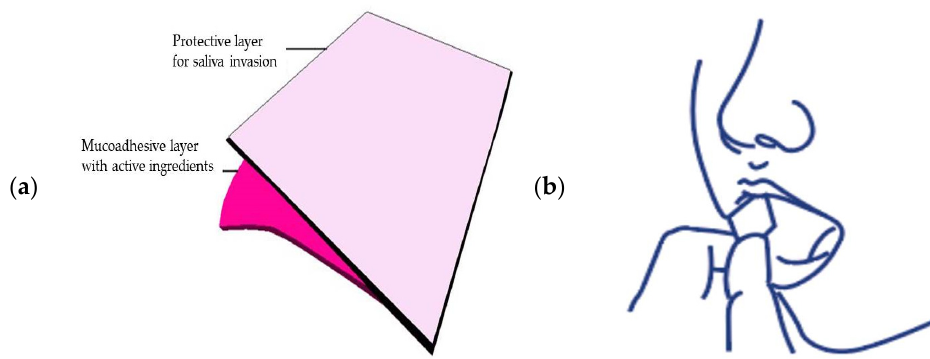
Figure 1. The schematic image of the double-layer buccal film ( a ) and intake method ( b ).